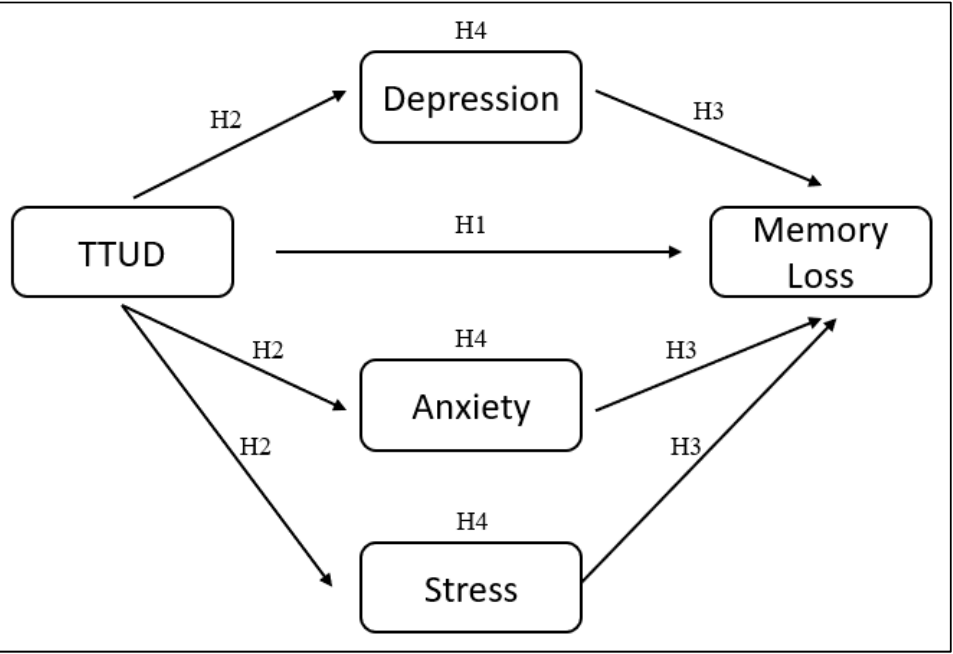
Figure 1. Structural model of hypotheses. Hypothesis 1 (H1): TikTok use disorder (TTUD) is positively linked to memory loss. Hypothesis 2 (H2): TTUD is positively linked to depression, anxiety, and stress. Hypothesis 3 (H3): Depression, anxiety, and stress are positively linked to memory loss. Hypothesis 4 (H4): Depression, anxiety, and stress have a mediating effect between TTUD and memory